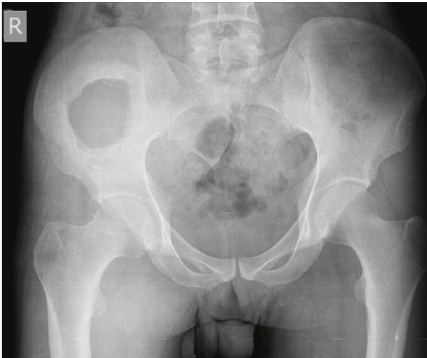
Figure 4: Organized hematoma with fibrin and scattered inflamma- tory cells, with no signs of malignant degeneration noted; the tumor consisted mainly of organized hematoma with a fibrous